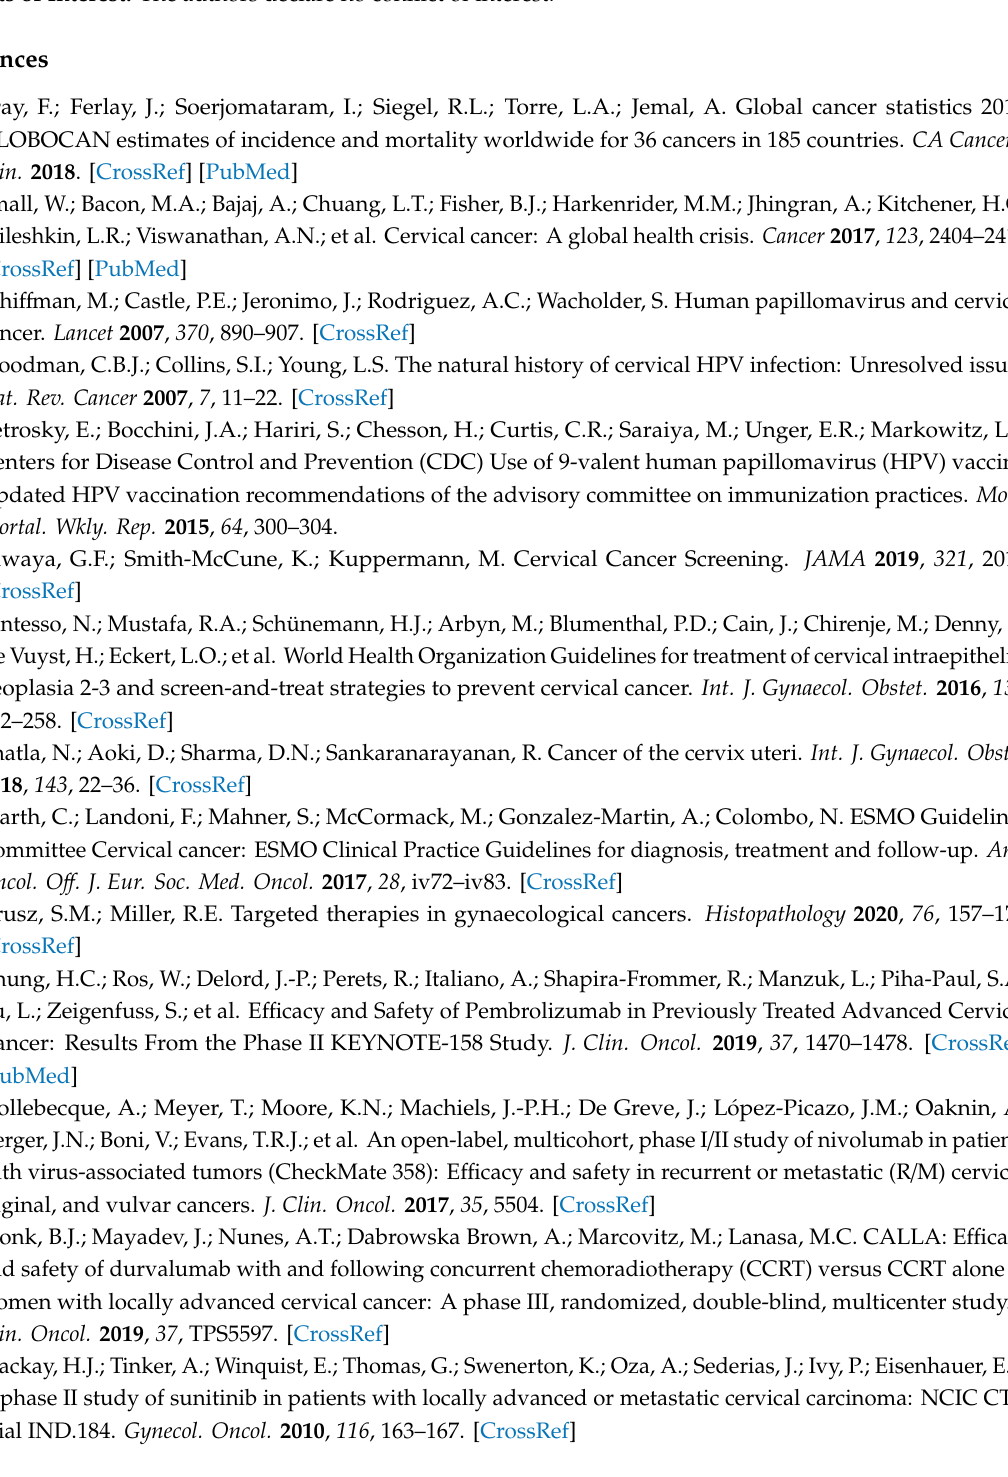
Table S1: Gene therapy clinical trials for cervical cancer compiled in The Journal of Gene Medicine Clinical Trial